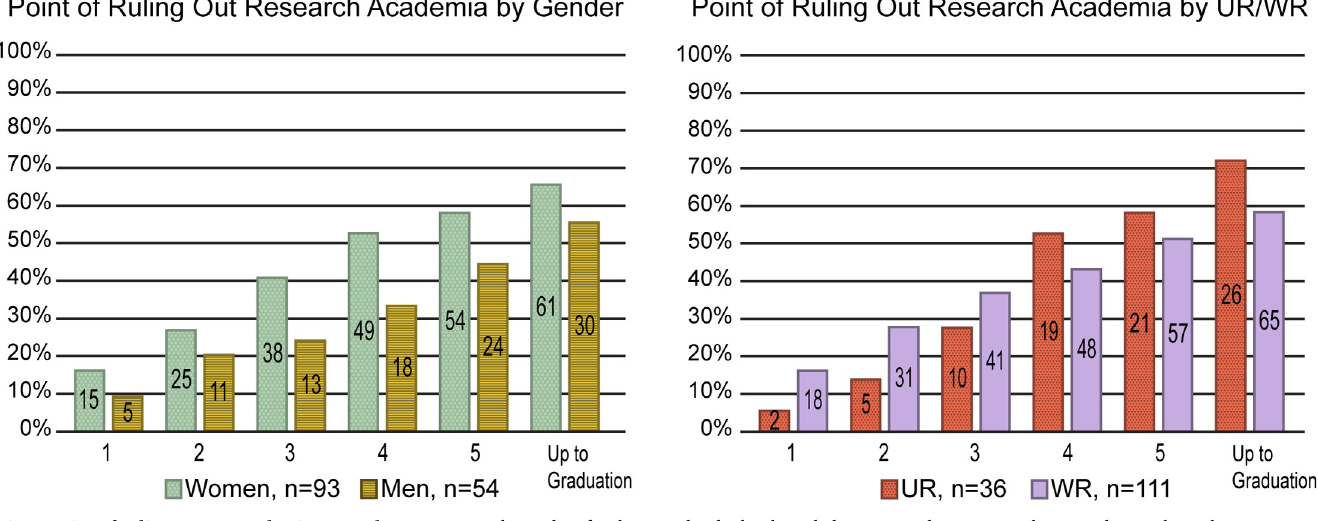
PLOS ONE | https://doi.org/10.1371/journal.pone.0234259 June 9,